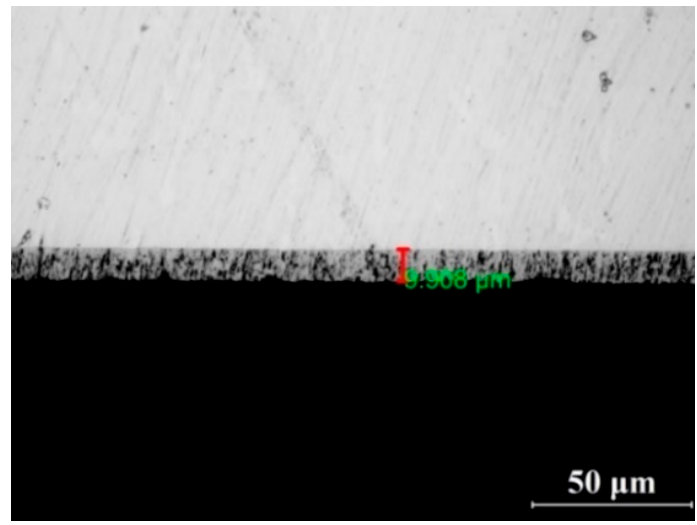
Figure 13. Measurement of the CrN-coated layer thickness by OEM.